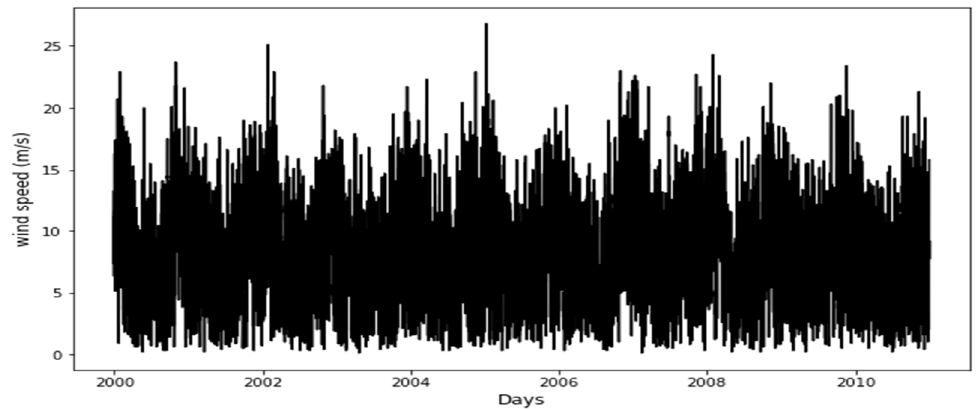
Figure 3. Raw measured wind speed datasets.